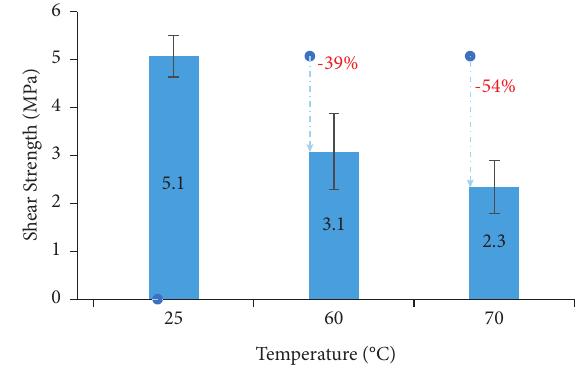
Figure 8: Lap shear test